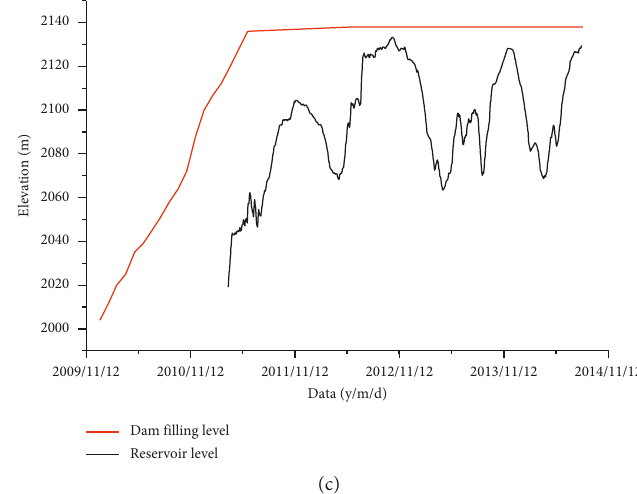
Figure 1: Information of the Maoergai gravel core rockfill dam. (a) Maximum cross section and layout of monitoring gauges. (b) Longitudinal section. (c) Dam construction and reservoir impounding